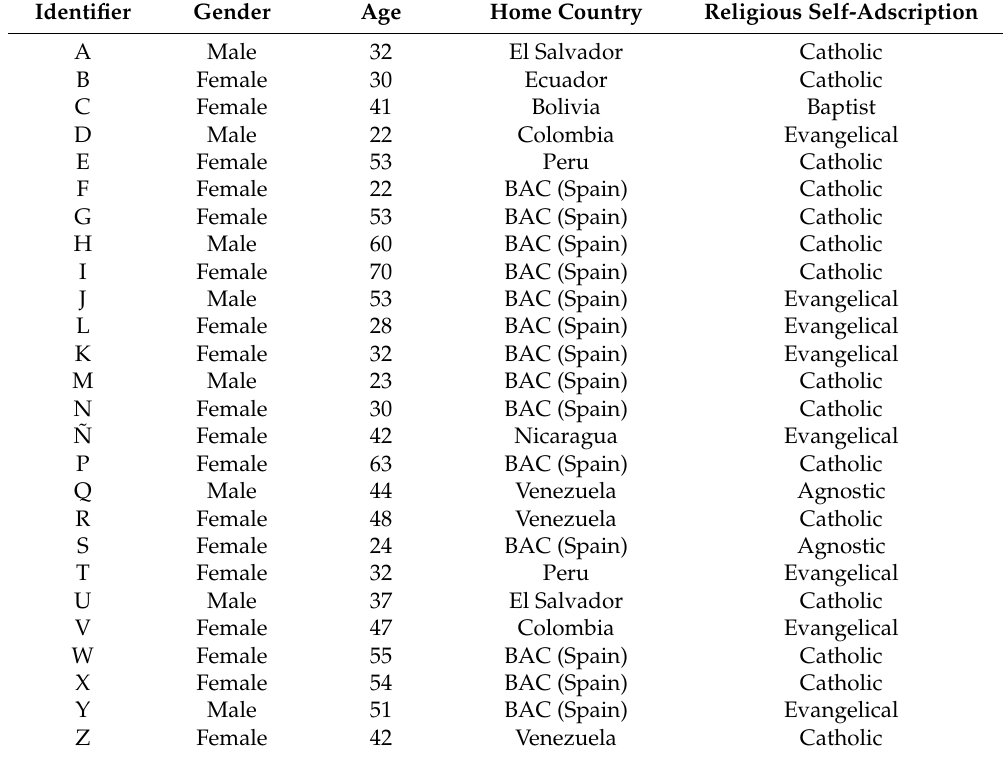
Table 1. List of interviewees. BAC, Basque Autonomous